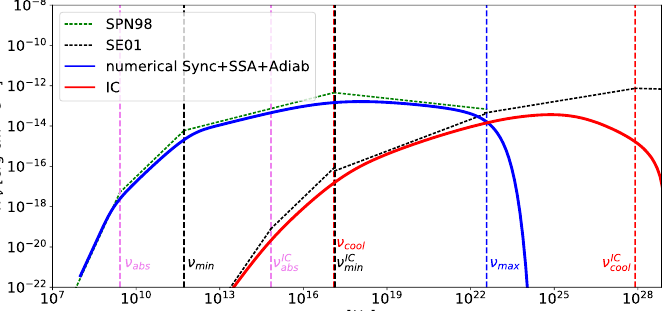
Figure 5. Comparison between spectra estimated with analytical approximations and numerical calculations. For the analytical method, the synchrotron emission (green dashed line) is estimated starting from [38] (SPN98, see legend) while the SSC (black dashed line) is taken from [48] (SE01). Vertical lines mark the break frequencies. The results from the numerical code described in Section 2.3 are shown with solid blue and red lines. This example shows the spectrum calculated at t = 10 4 s for s = 0, p = 2.3, (cid:101) e = 0.05, (cid:101) B = 5 × 10 − 4 , E k = 10 52 erg, n 0 = 1 cm − 3 , Γ 0 = 400 and z =